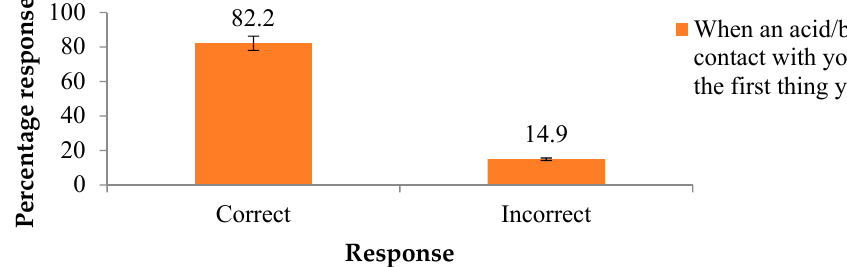
Figure 8. Percentage distribution of students’ response for the questions on Emergency Equipment and Procedures (Question 30).